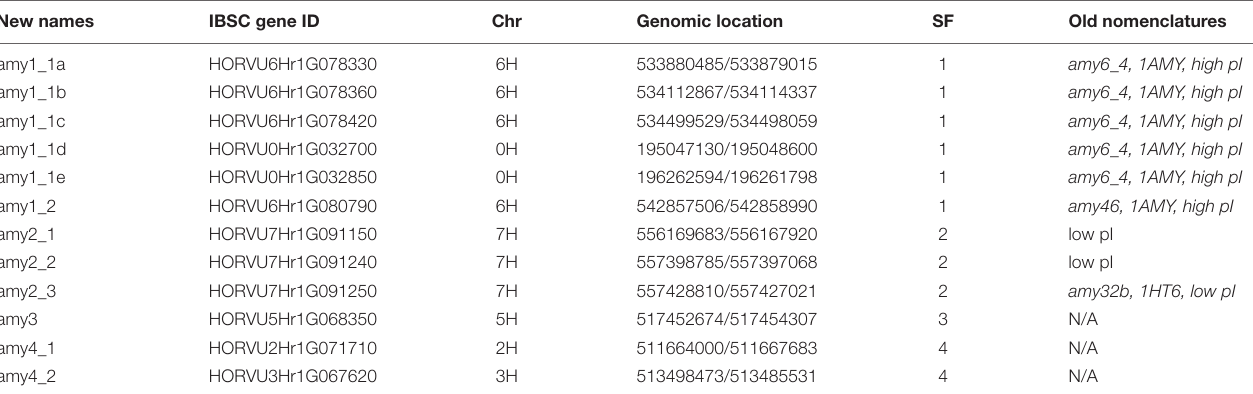
TABLE 1 | Barley amy nomenclatures, gene ID, locations, and the association of old and new